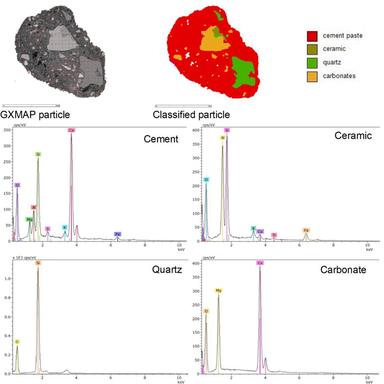
Phase's discrimination at SEM-IA using by BSE gray level and EDS spectra. "Reprinted figure from "Quantification of the cement paste and phase's association in fine recycled aggregates by SEM-based image analysis" with permission from Elsevier." License number 5733040190800.